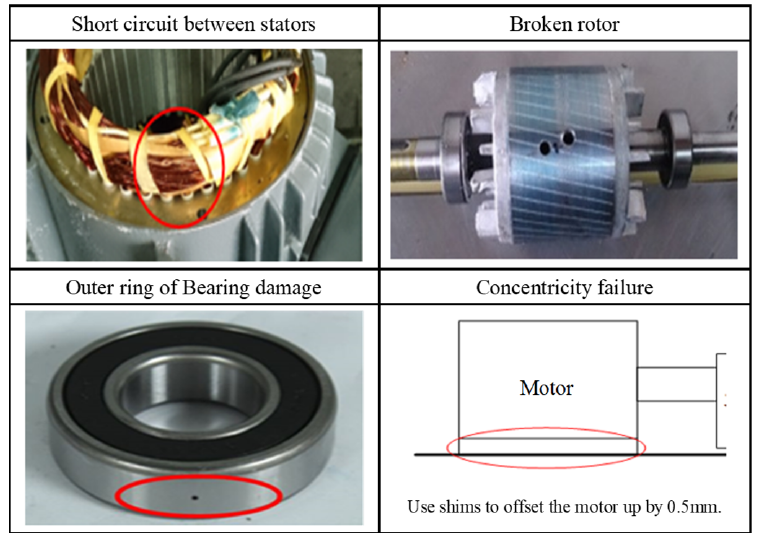
Figure 2. Induction Motor Defect Model. * red circle: the area that caused the blemish.